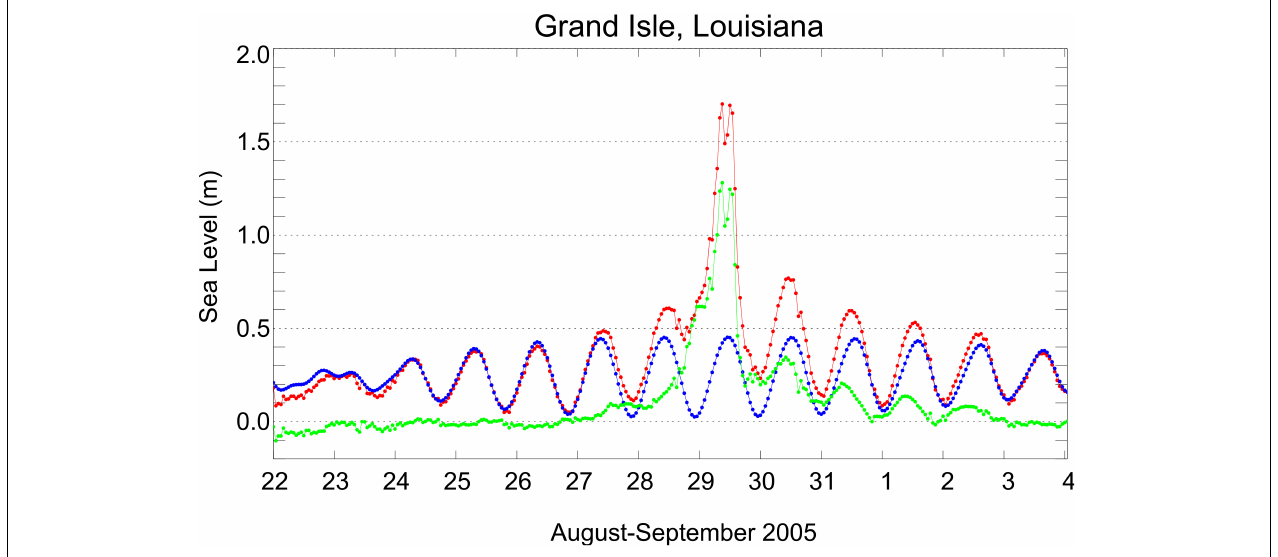
FIGURE 2 | Observed (red), tidal (blue), and meteorological (green) variations of sea level at Grand Isle, Louisiana during Hurricane Katrina, 28–30, August 2005. From Pugh and Woodworth (2014).